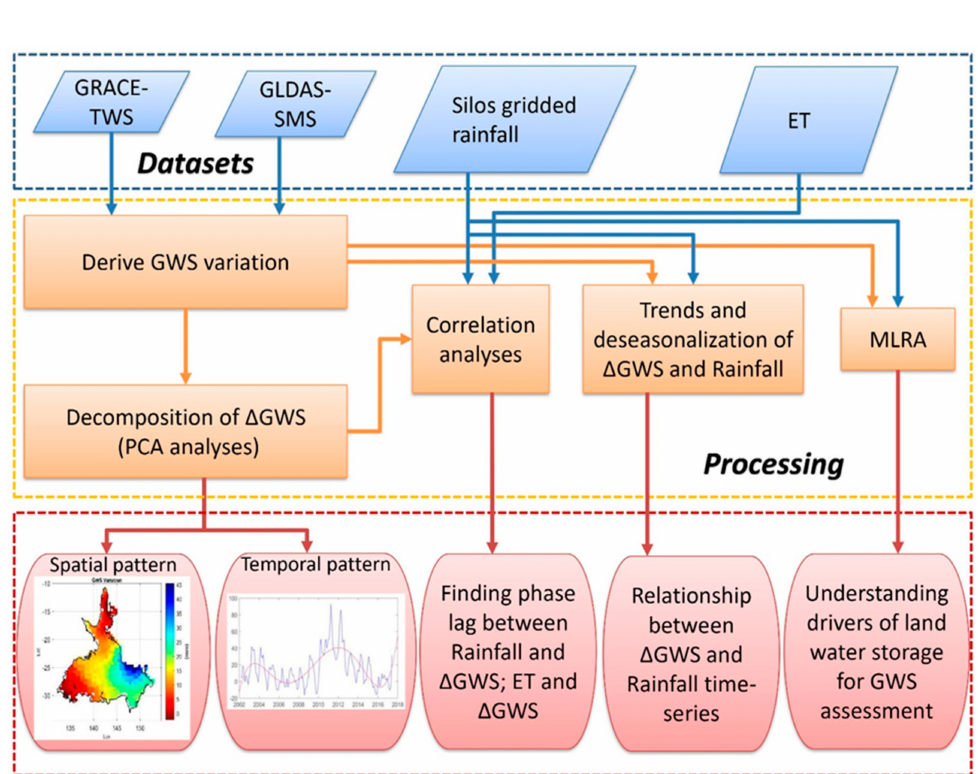
Figure 2. Methodology flowchart to assess GWS variations and its